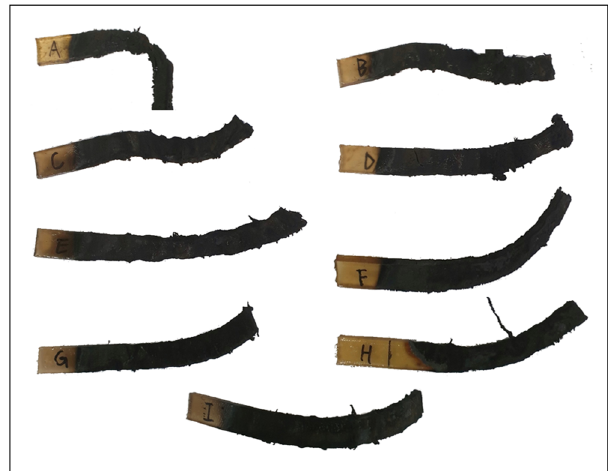
Figure 3: Schematic representation of nine di ff erent specimens for the core after burning in the horizontal burning